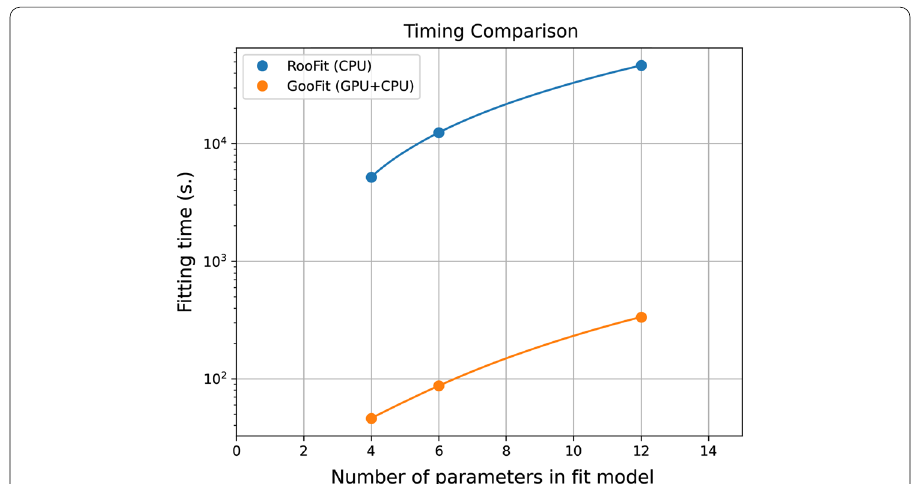
Fig. 2 Comparison of time required by RooFit (CPU-based) and GooFit (GPU to fit three data sets of 10,000 pseudo-experiments, each generated and fitted according to models of increasing complexity in terms of the number of K ∗